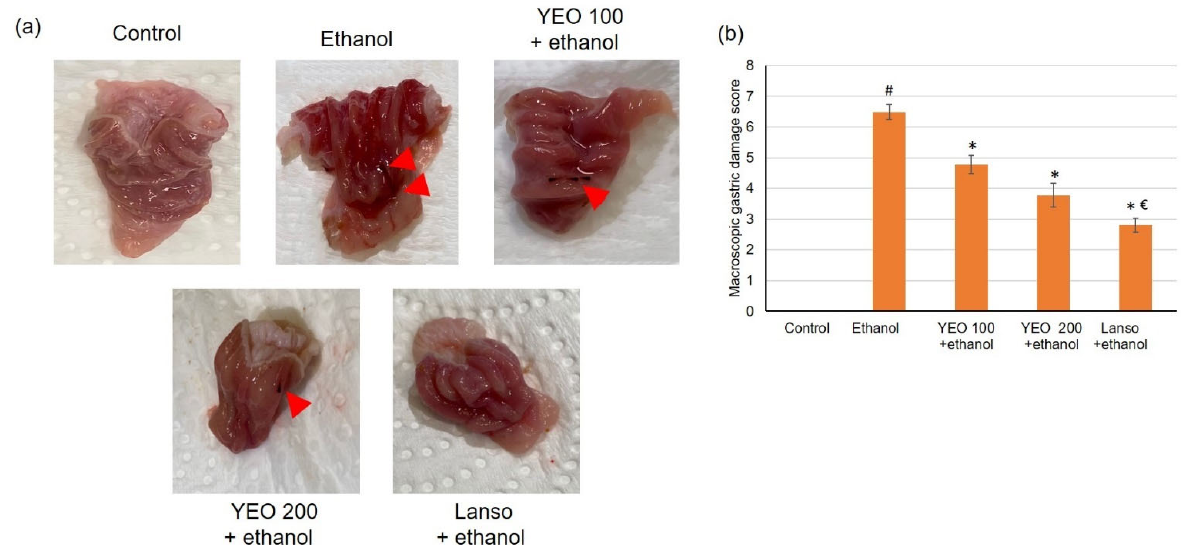
Figure 1. The actions of YEO (100 and 200 mg/kg) administration in acute gastric mucosal injuries induced by ethanol in rats on ( a ) demonstrative images of the separated gastric and ( b ) gastric injury scores. All data are quantified as mean ± SE, ( n = 6 ). (#) defines statistically significant related to the control, (*) signifies statistically significant related to the ethanol-induced gastric mucosal injuries, and ( € ) designates statistically significant related to YEO 200 + ethanol via one-way ANOVA afterward Tukey’s post hoc test ( p < 0.05).